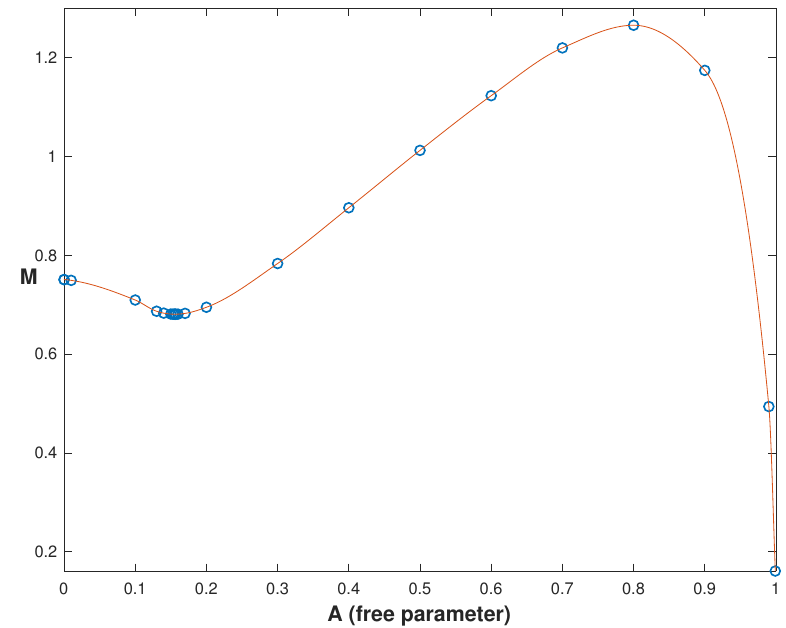
Figure 8. Proper energy (mass) M against the free parameter A = f ( 0 ) for the neutral